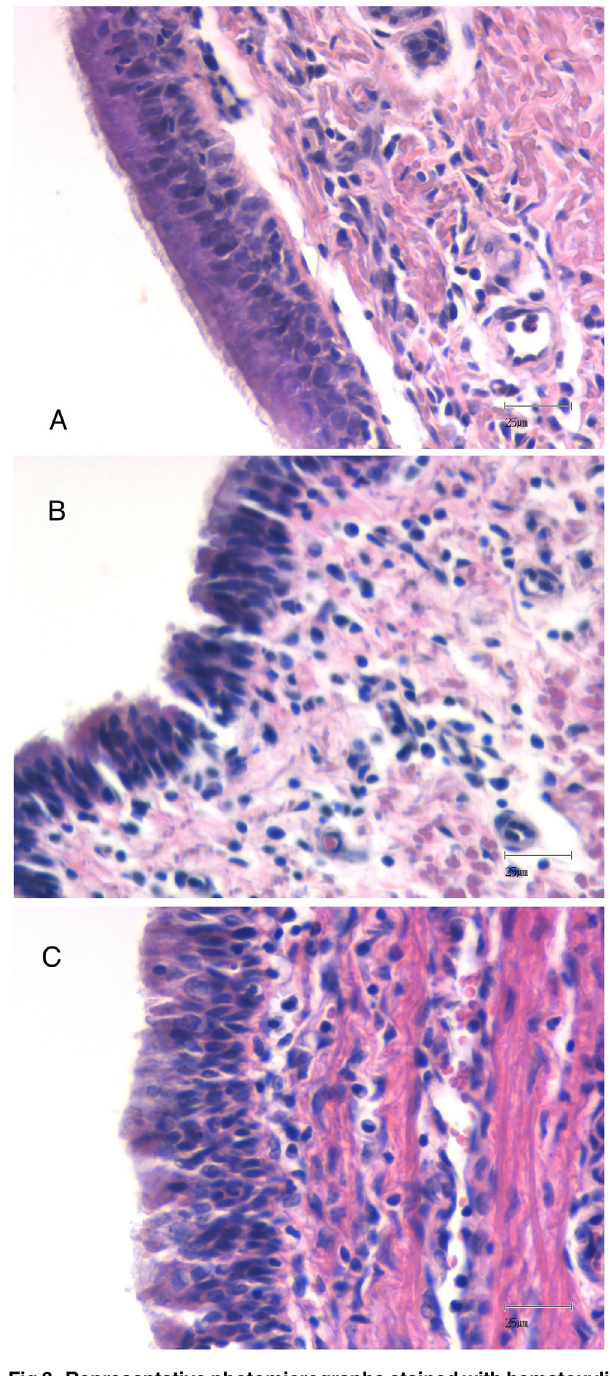
Fig 3. Representative photomicrographs stained with hematoxylin and eosin from tracheal epithelial tissue obtained at the end of the experiment in the control (panel A) and CPB groups (panels B and C). Panel A show the presence normal ciliated epithelium in the control group. On the other hand, panels B and C show regions of epithelial cilia loss and submucosal neutrophil infiltration in the CPB group.